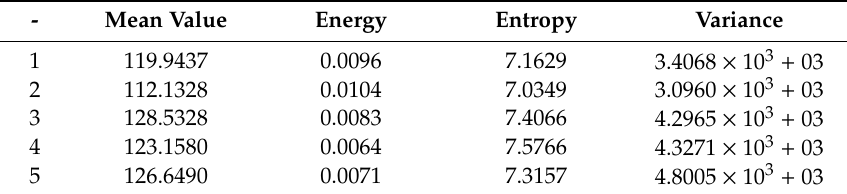
Figure 16. Brake light brightness change chart during on and off processes. Table 6. Correlation coefficient for taillight candidate region.